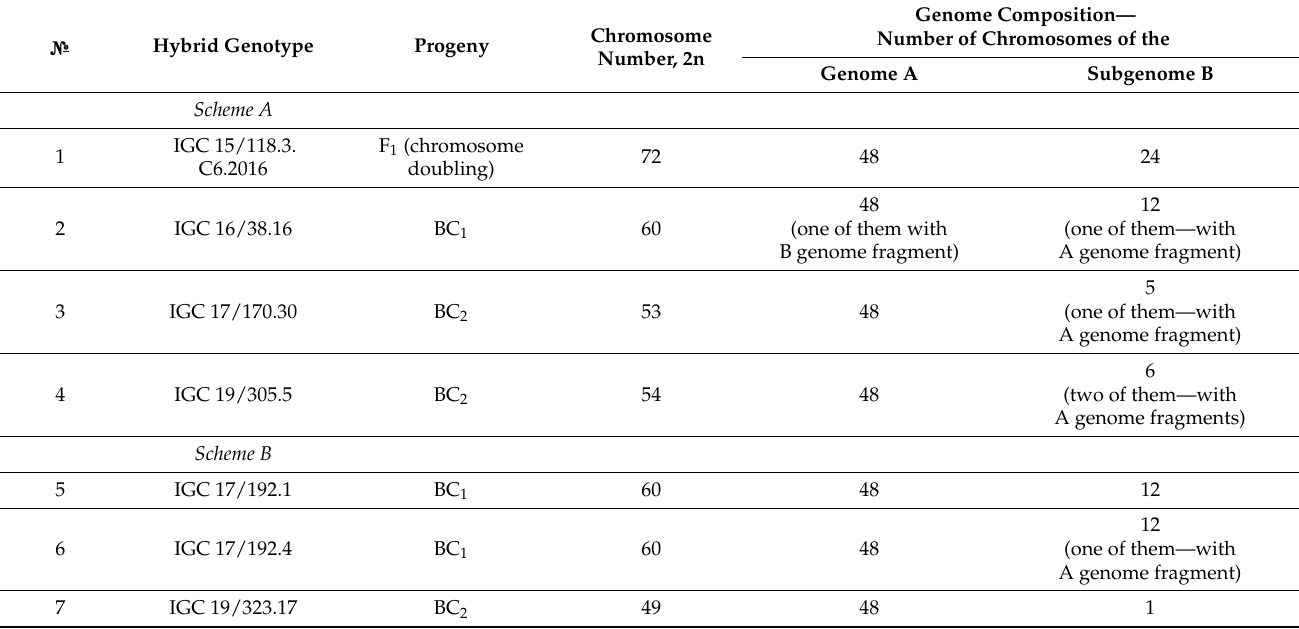
Table 1. Genomic constitution of the backcross hybrids of cultivated potato with S. stoloniferum .